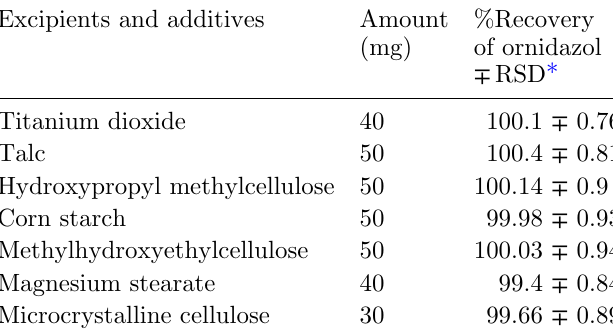
Table 4. Determination of ornidazole in presence of excipients and additives [16].